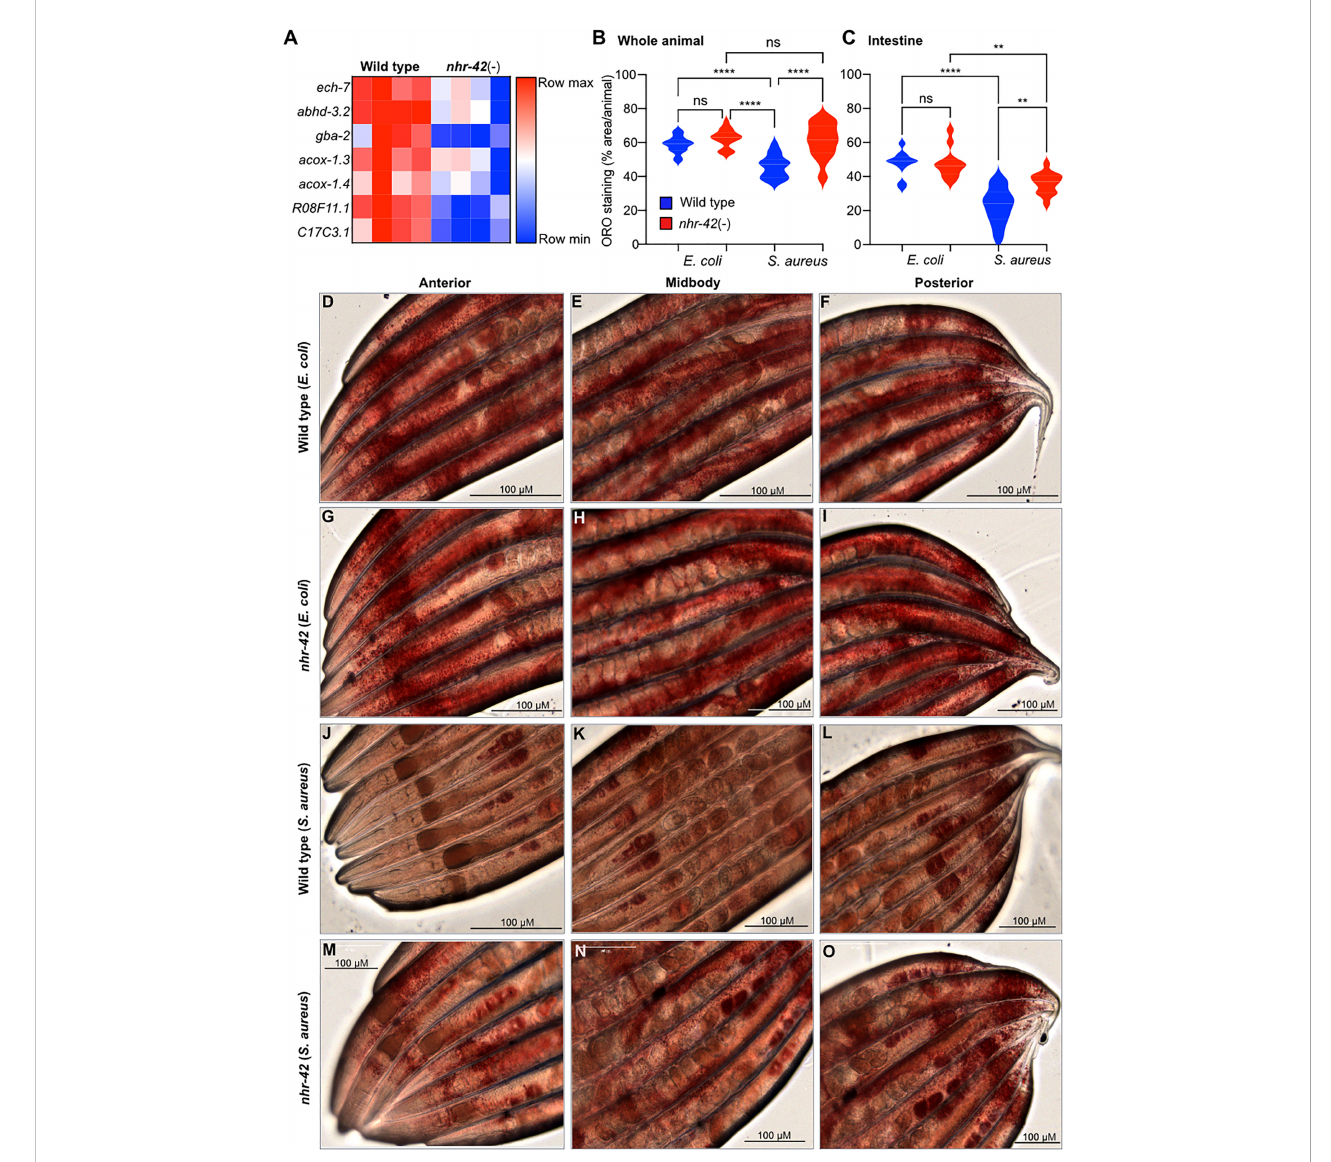
FIGURE 4 nhr-42 is required for lipid loss during infection (A) Lipid catabolism genes downregulated in noninfected nhr-42 (tm1375) mutants relative to wild type. Row-normalized FPKM values. (B) Quanti fi cation of Oil Red O staining in whole wild type and nhr-42 (tm1375) animals. **** P ≤ 0.0001. ns, not signi fi cant. One-way ANOVA with S ̌ ı ́ da ́ k ’ s post-hoc test. Representative of 3 independent replicates, 10-20 animals per condition. (C) Quanti fi cation of Oil Red O staining in the intestines of wild type and nhr-42 (tm1375) animals. ** P ≤ 0.01. One-way ANOVA with S ̌ ı ́ da ́ k ’ s post-hoc test. Representative of 3 independent replicates, 10-20 animals per condition (D – F) ORO staining of wild type animals fed with E. coli OP50 for 10 h (G – I) ORO staining of nhr- 42 (tm1375) animals fed with E. coli OP50 for 10 h (J – L) ORO staining of wild type animals infected with S. aureus SH1000 for 10 h (M – O) ORO staining of nhr-42 (tm1375) animals infected with S. aureus SH1000 for 10 h. Scale bars: 100